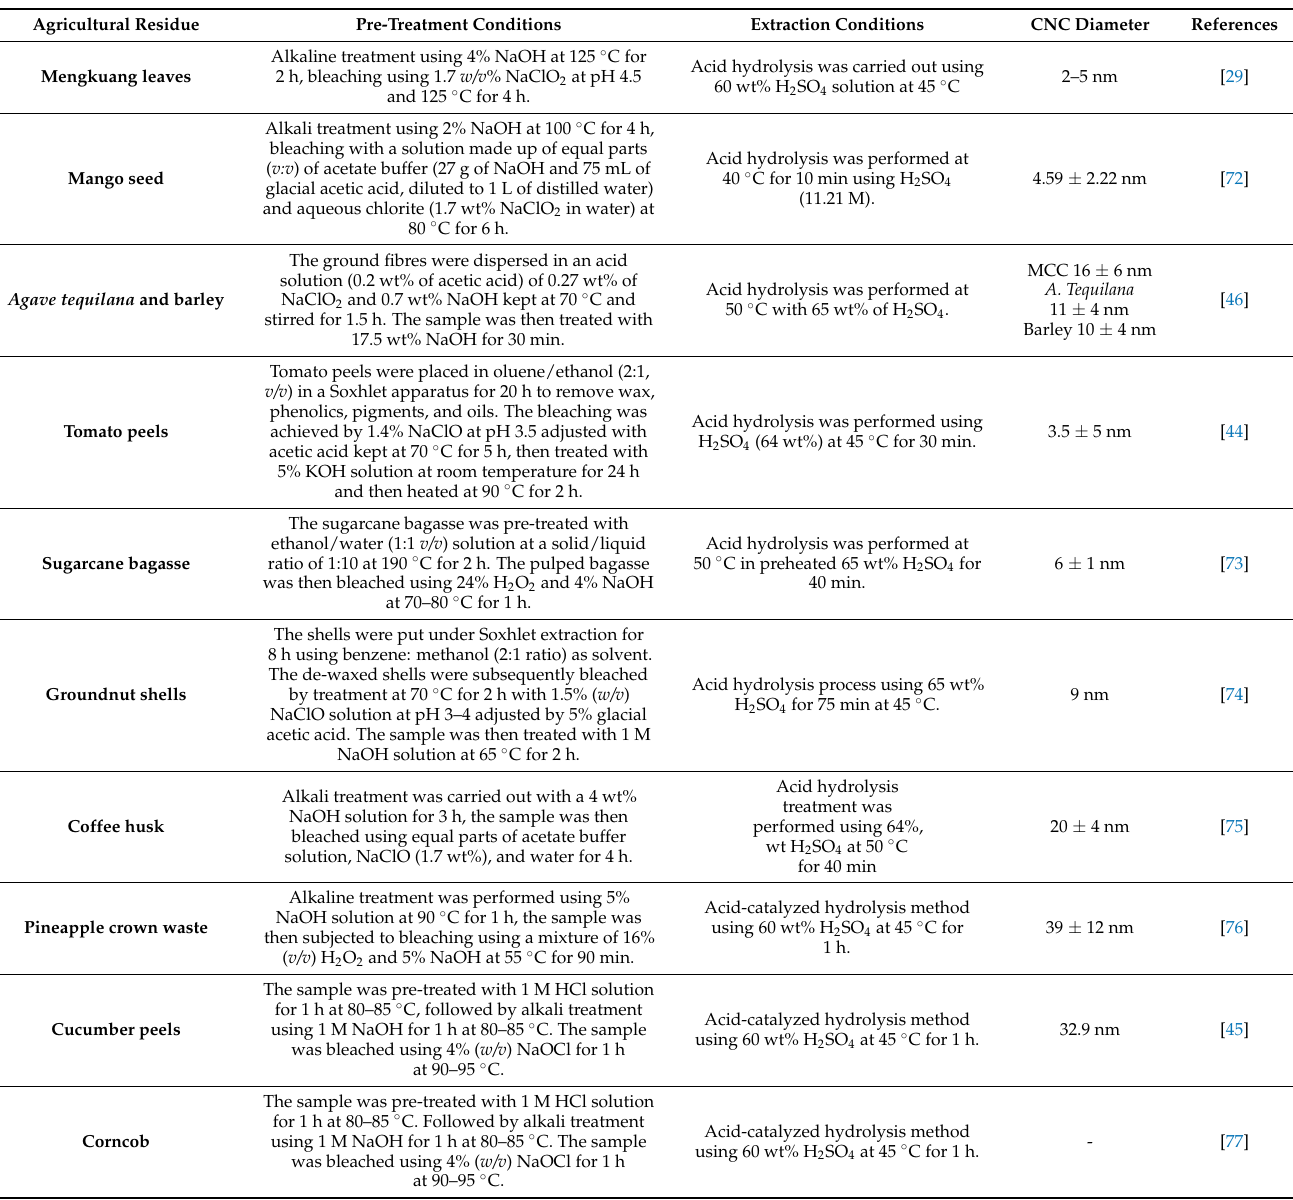
Table 1. Selected articles showing the extraction of CNCs from different agricultural residues in the past